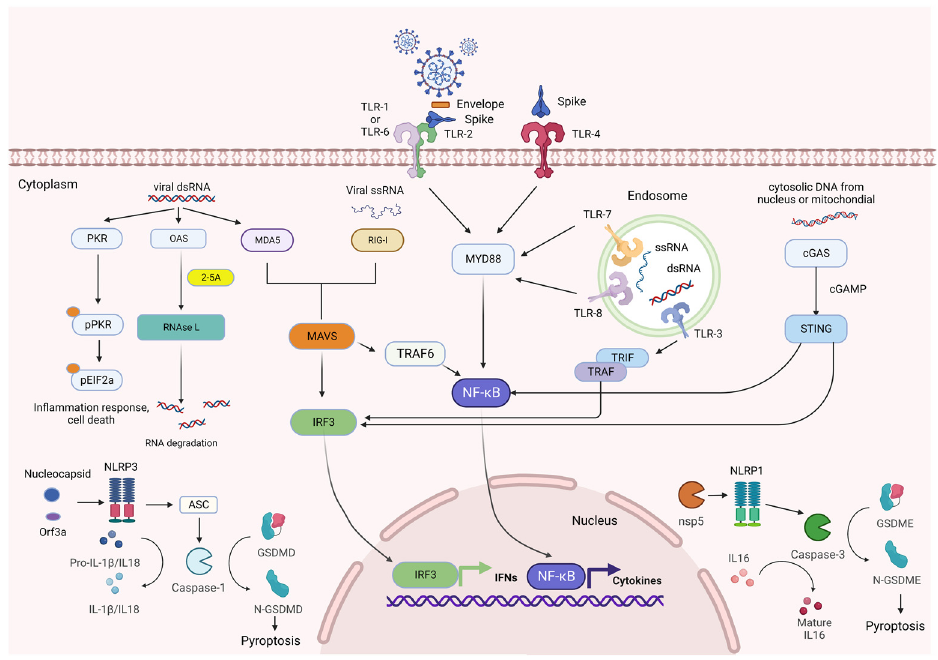
Figure 2. SARS-CoV-2 viral components could be sensed by the innate immune system via PRRs including toll-like receptors, RIG-I-like receptors, NOD-like receptors, and other cellular sensors. Viral RNA components could be sensed by toll-like receptors TLR3, TLR7, TLR8; RLR RIG-I, and MDA5, together with OAS and PKR. SARS-CoV-2 proteins could be detected by TLR2, TLR4, NLRP3, and NLRP1. SARS-CoV-2 infection leading to the release of DNA from the nucleus and mitochondrial could be detected by cGAS and initiate downstream